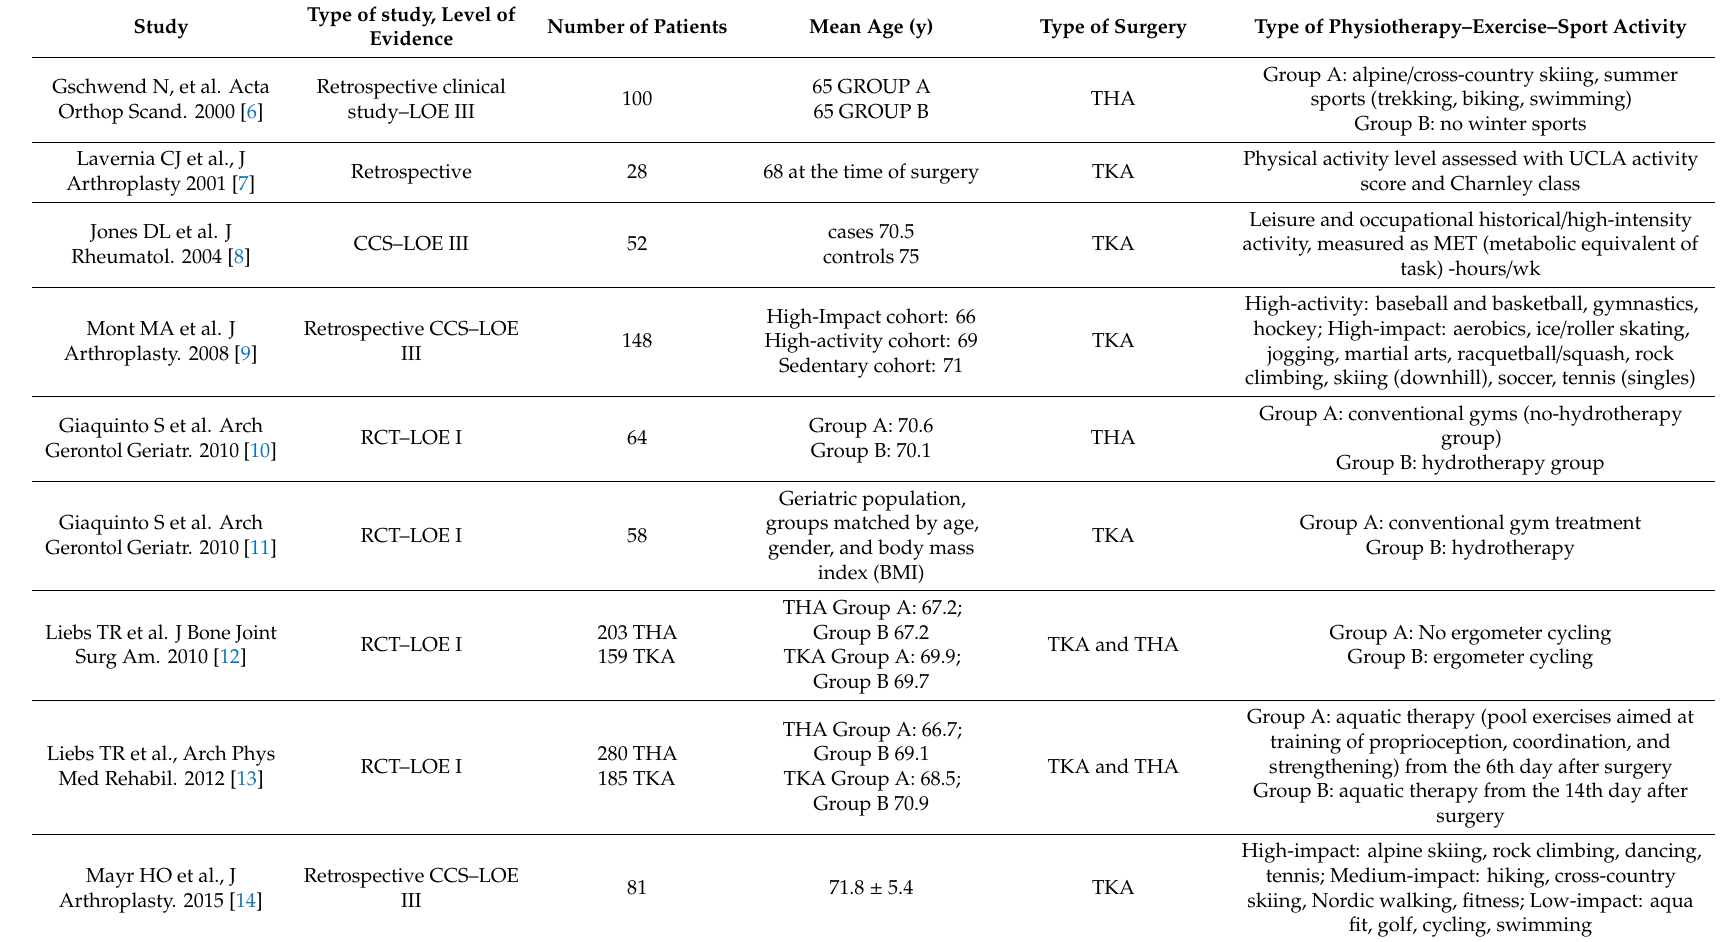
Table 1. Details of the included